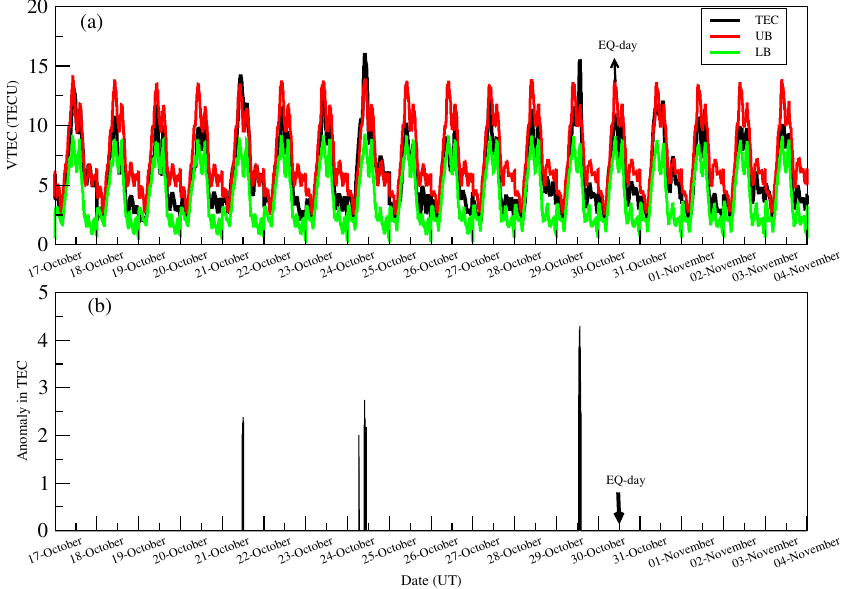
Figure 3. ( a ) The diurnal variation of TEC (black line) from 17 October to 4 November, the 2020 Samos EQ along with the upper (red line) and lower (green) bound (upper panel). ( b ) The lower panel shows the fluctuations in TEC. The day of the EQ is marked with an